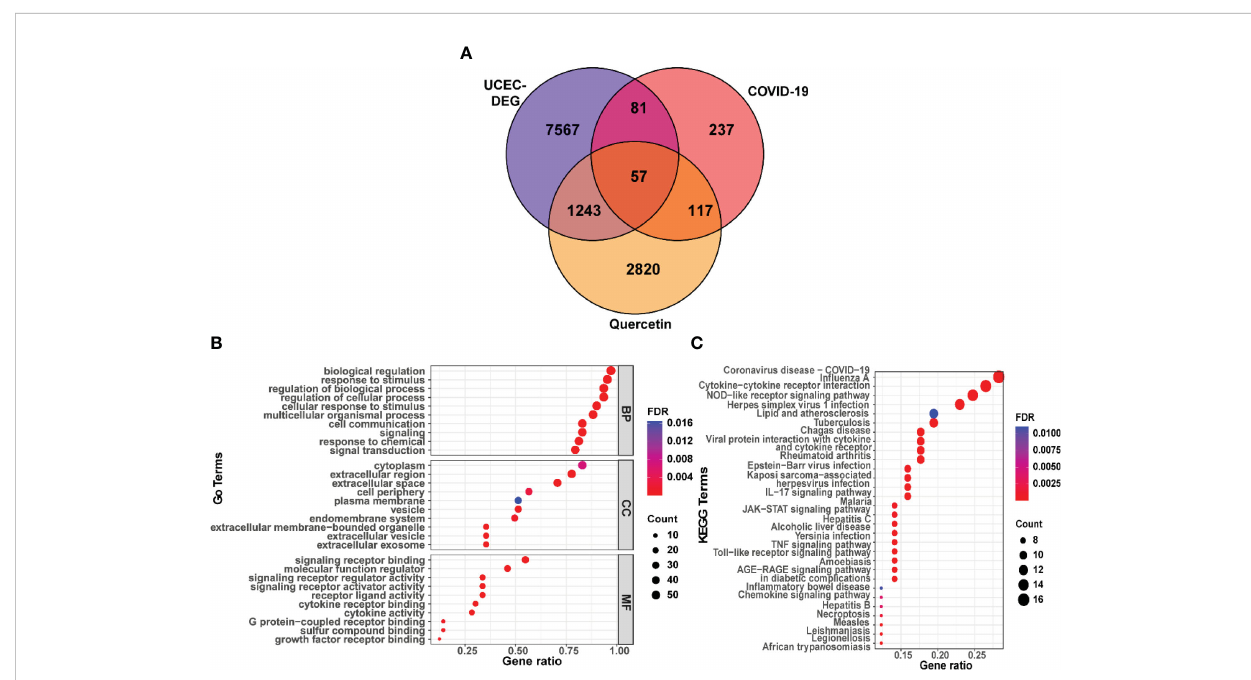
FIGURE 3 Functional characterization of quercetin against UCEC/COVID-19 intersecting genes. (A) Venn diagram describing intersecting genes of quercetin and UCEC/COVID-19. (B) GO analysis of intersecting genes of quercetin and UCEC/COVID-19. (C) KEGG pathway analysis of intersecting genes of quercetin and